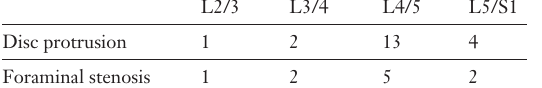
Location of disc her- niations and forami- nal stenosis.